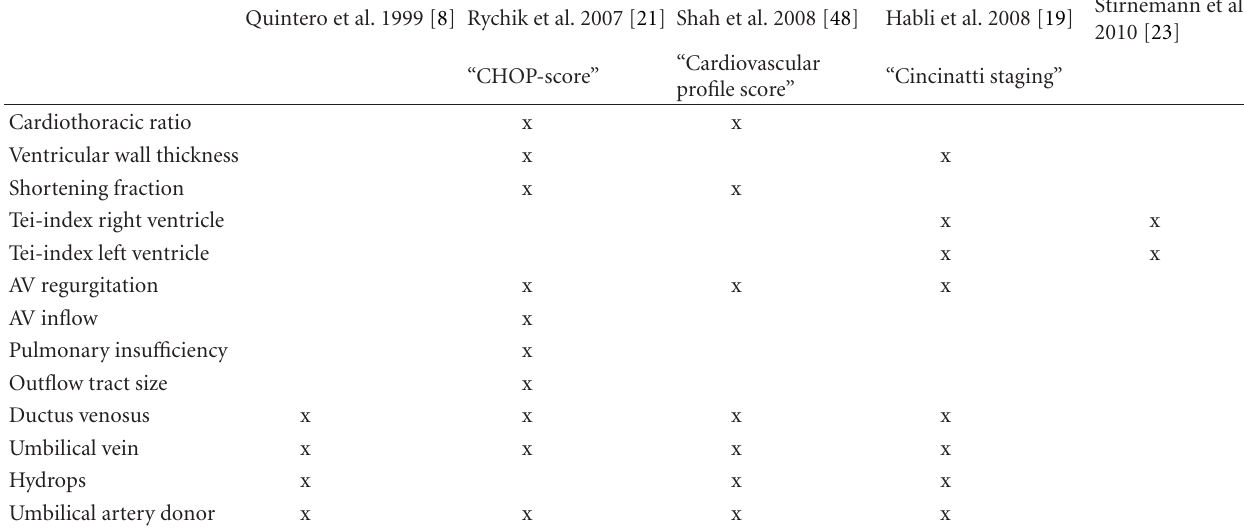
Table 2: Comparison of the cardiac parameters assessed in the di ff erent proposed staging